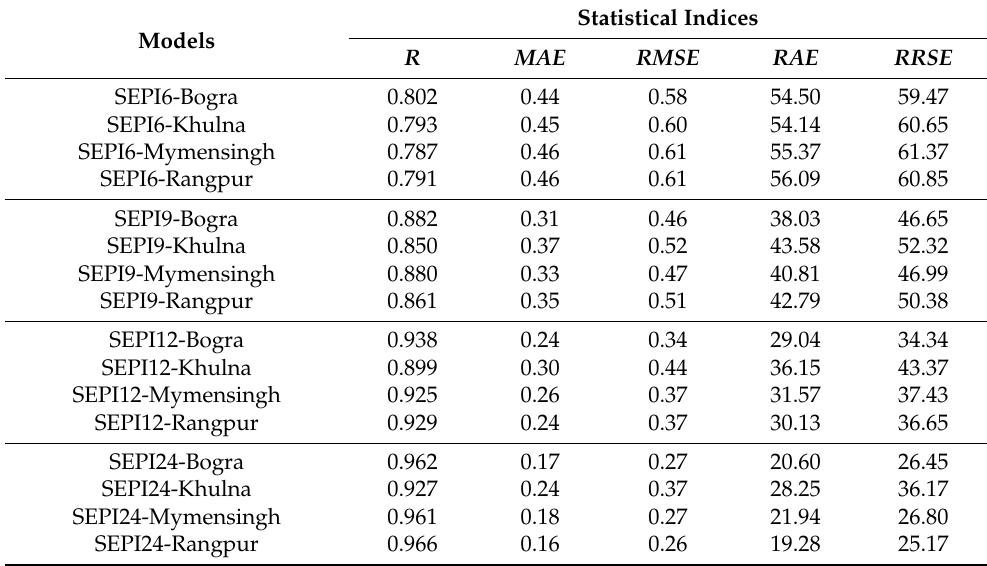
Table 6. Statistical performance of M5P model in predicting SPEIs at the test